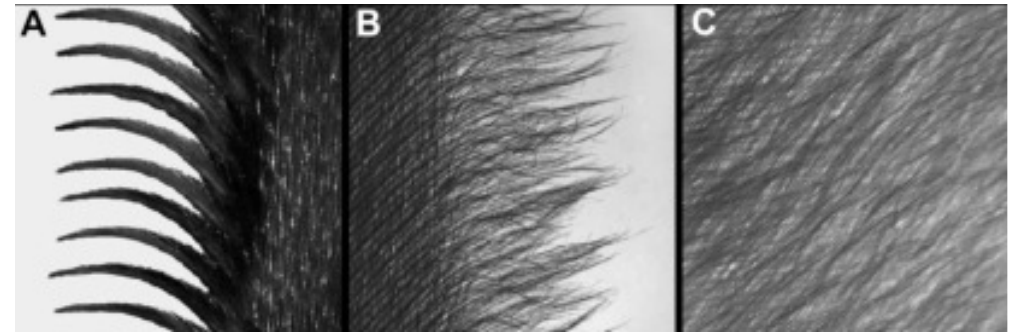
Figure 1. Details of the three special feather adaptations of the barn owl (redrawn from [21]): ( A ) leading edge serrations; ( B ) trailing edge fringes; and ( C ) soft downy coating